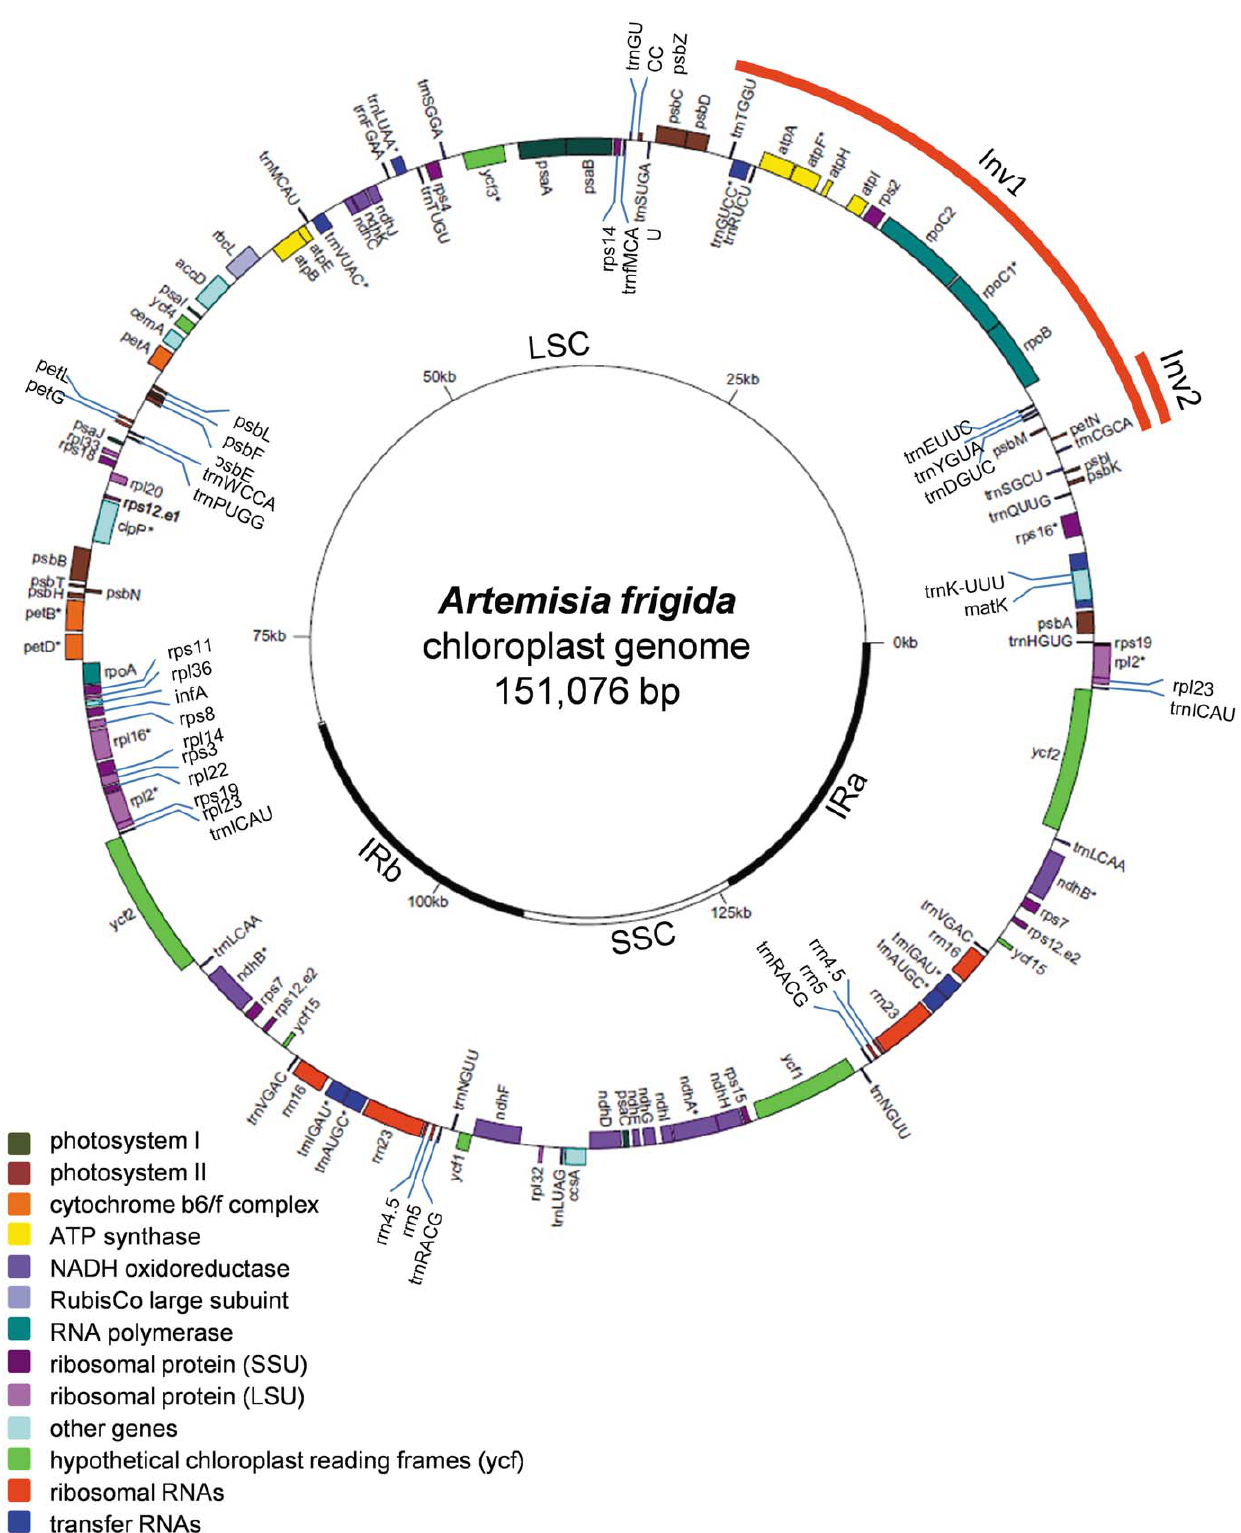
Figure 1. The map of the chloroplast genome of Artemisiafrigida . IR, inverted repeat; LCS, large single copy region; SSC, small single copy region; Inv1, inverted sequence region 1; Inv2, inverted sequence region 2. Genes containing introns are marked with *.